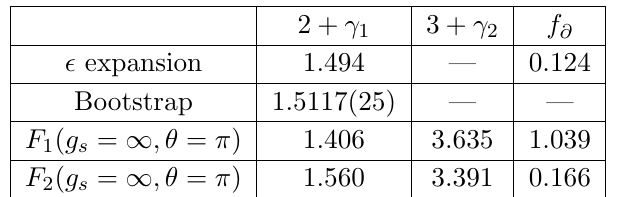
Table 1 . Comparison of the extrapolations with the known data: for the energy operator we are quoting the value from the conformal bootstrap [66], and from the (cid:15) -expansion [67]. For the sphere free energy we are comparing to the value from the (cid:15) -expansion in [68].